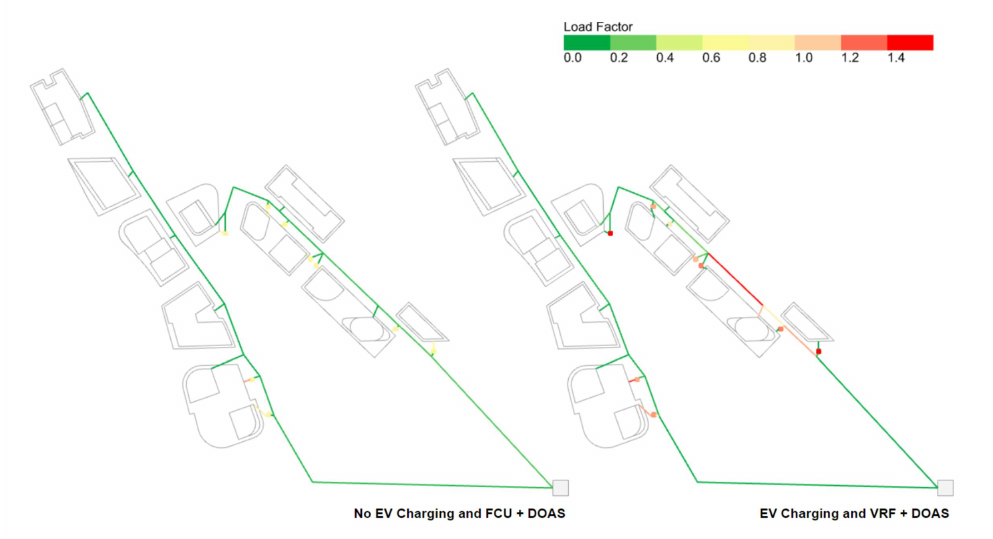
Figure 19. Peak loading of electrical infrastructure between electrified and non-electrified